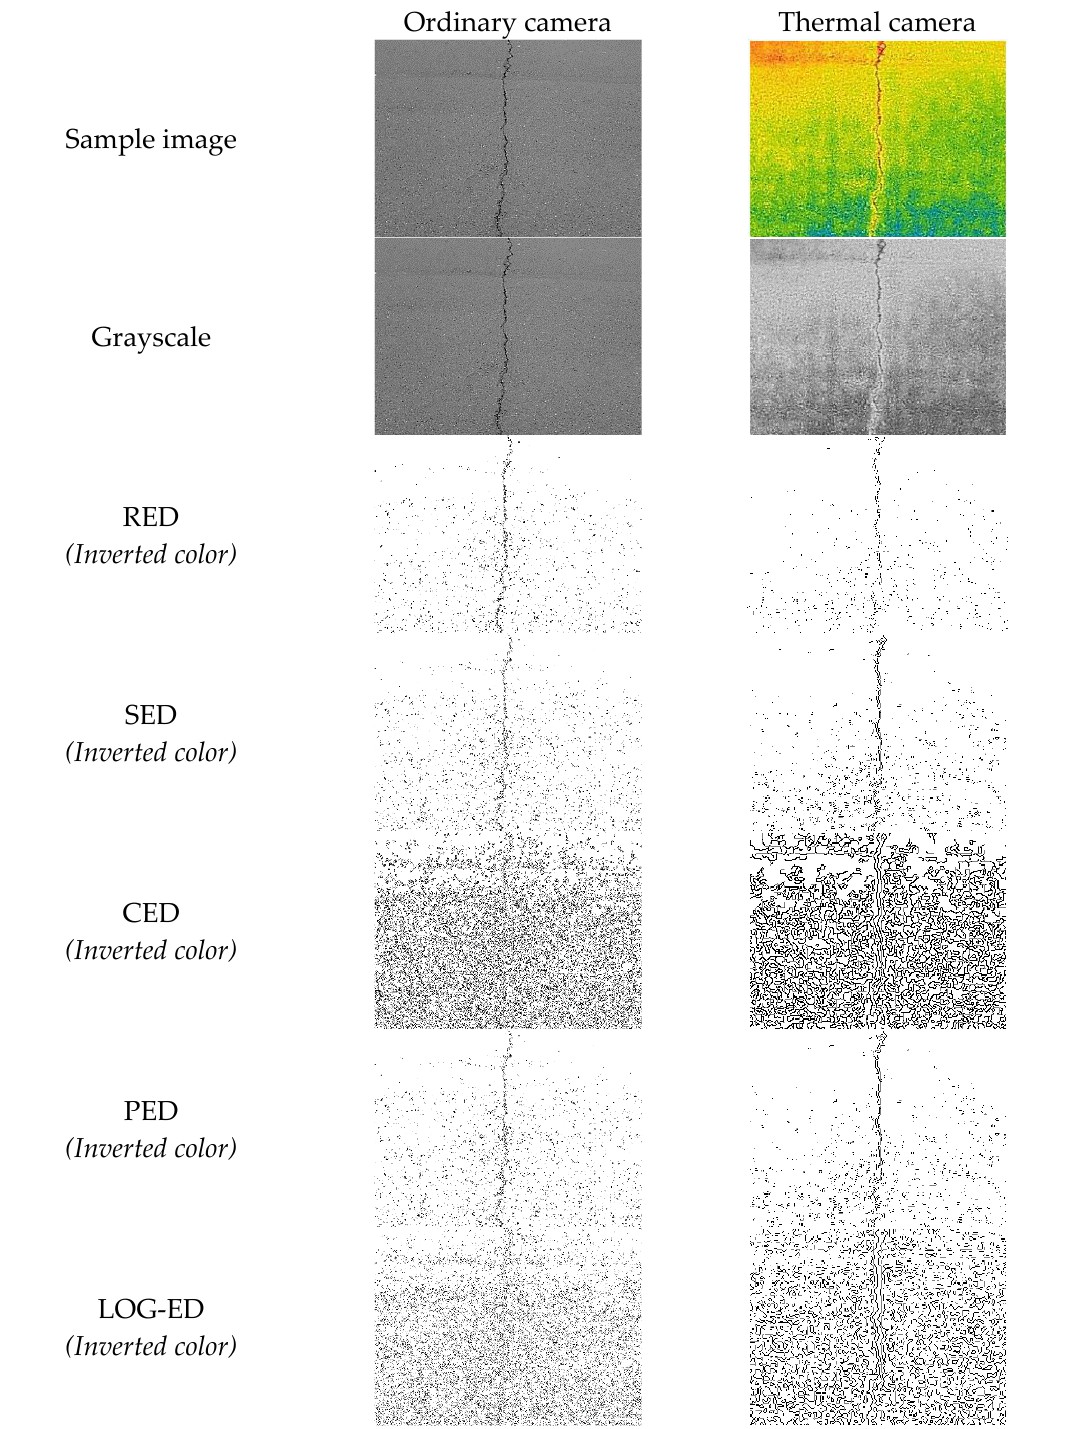
Figure 3. Comparison of sample images taken from ordinary and thermal cameras.